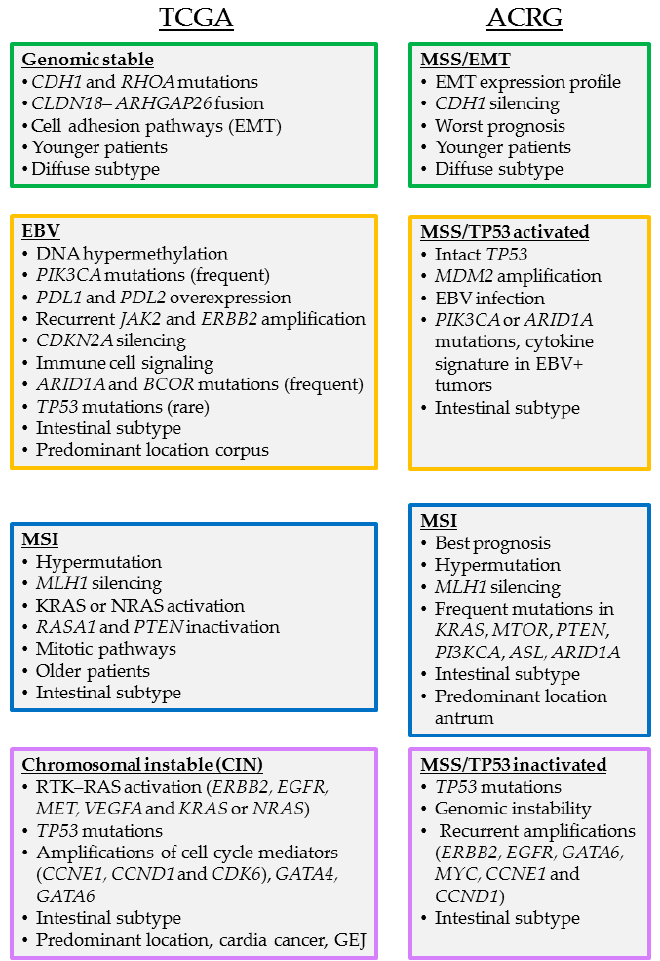
Figure 1. Molecular classification of gastric cancer into distinct subtypes according to TCGA and ACRG.